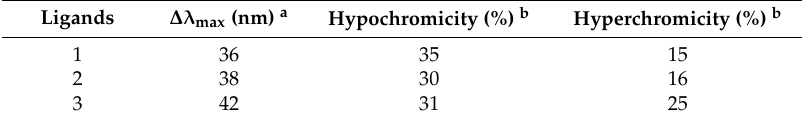
Figure 3. Spectrophotometric titration of ligand 2 (6 µ M) with GQ c-KIT 1 (0–30 µ M) in Tris-HCl buffer (10 mM, pH 7.2) containing 100 mM KCl ( A ). Panel ( B ) shows normalized absorbance changes vs. increasing concentration of c-KIT 1 G-quadruplex at 515 nm (ligand 1 ), 521 nm (ligand 2 ), and 508 nm (ligand 3 ). Table 1. Spectral effects for the ligands 1 – 3 bound to c-KIT 1 GQ DNA.